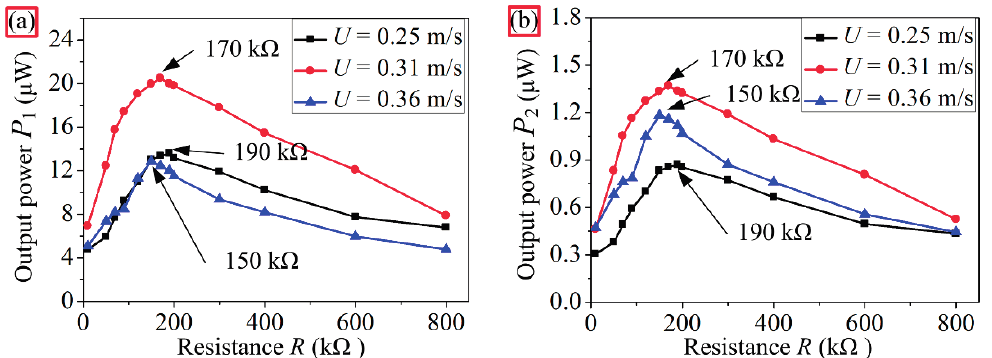
Figure 4. Relationship between the resistance R and the output power P at velocities of 0.25 m/s, 0.31 m/s, and 0.36 m/s: ( a ) upstream beam; ( b ) downstream